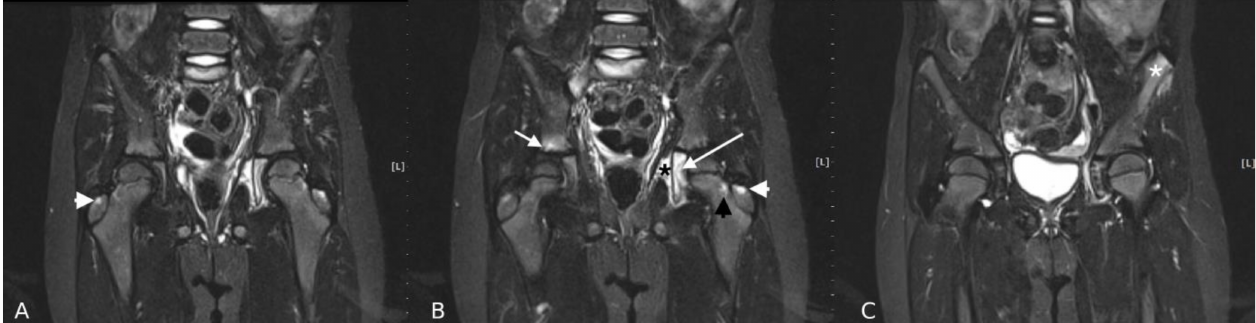
Figure 2. MRI of the hips in a 7-year-old girl with JIA. ( A – C ) Coronal T2 TIRM images. Right hip: BME in the greater Table 1. (arrowhead) and in the acetabulum (stage 1) (white short arrow). Left hip: BME in the greater trochanter (stage 1) (white arrowhead), in the acetabulum (stage 2) and triradiate cartilage (stage 1) (white long arrow) and in the femoral neck (stage 1) (black arrowhead). Obturator internus myositis (stage 1) (black asterisk). Left anterior superior iliac spine (ASIS) enthesitis (white asterisk). Right sided